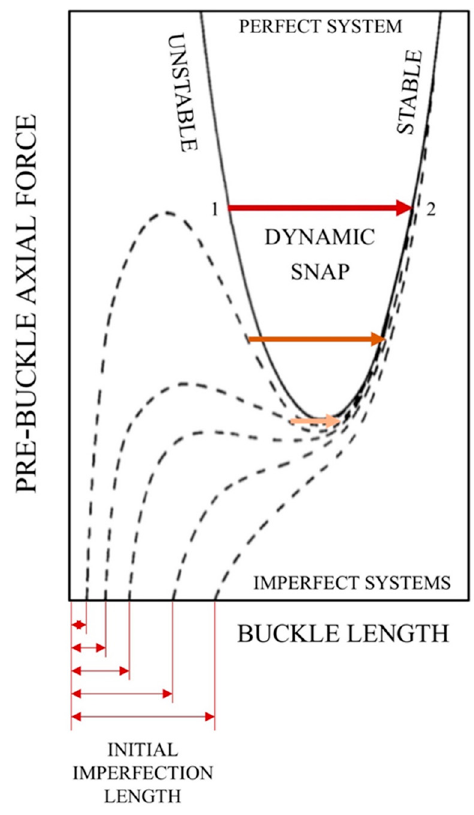
Figure 1. Imperfection sensitivity of equilibrium paths (adapted from Hobbs [2]): the transition from mechanical instability to stability happens at lower forces and less dramatically in the presence of an initial crookedness, to be eventually replaced by a progressive enlargement of the imperfection.